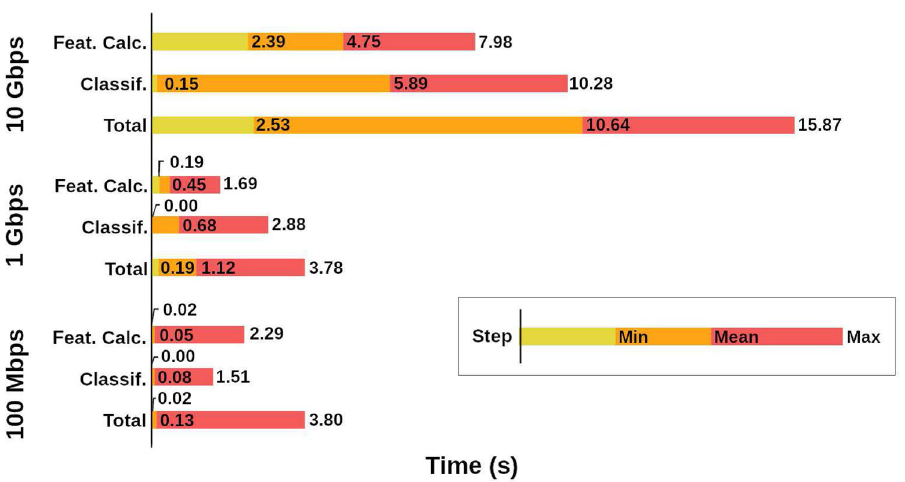
Figure 4. Maximum, mean and minimum time (s) required to calculate features, classify samples and the total process if the system used time windows of one second in traffic bandwidths of 100 Mbps, 1 Gbps and 10